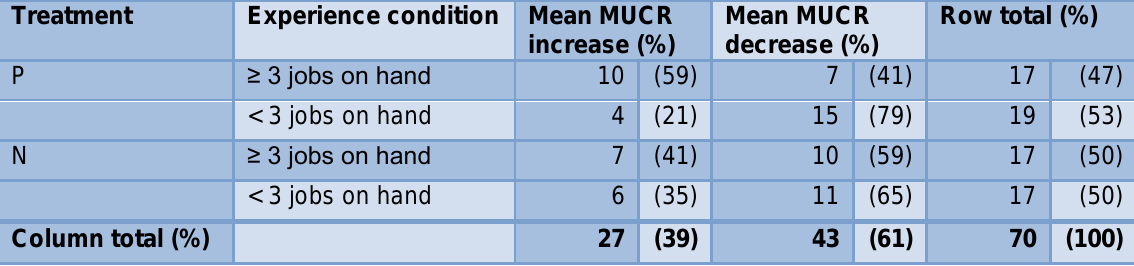
Table 3 Frequencies of bid changes in rounds